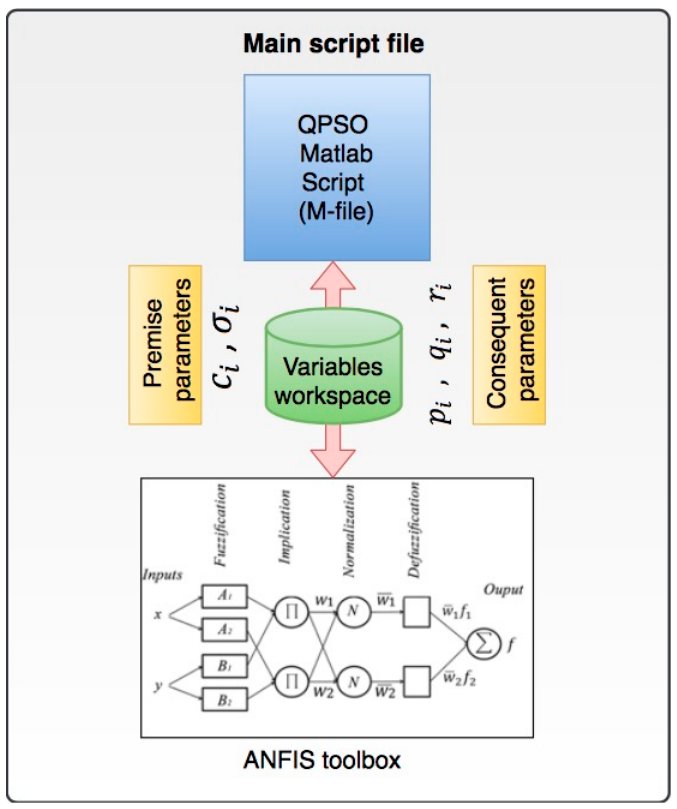
Figure 2. ANFIS-QPSO integration structure.